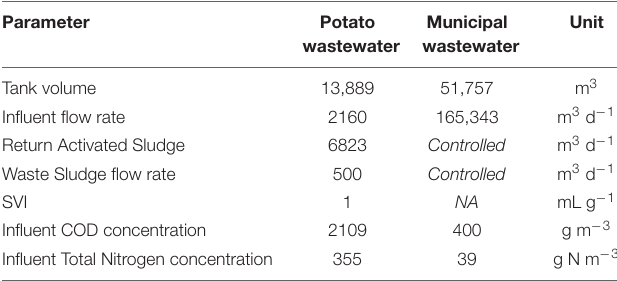
TABLE 2 | Model specifics of the two considered